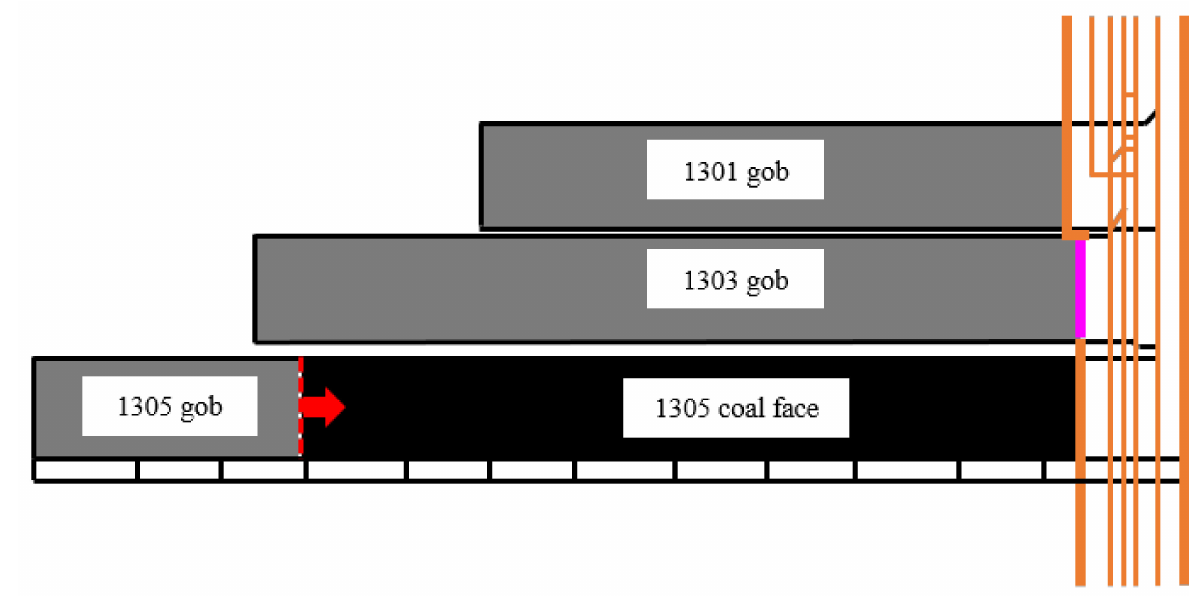
Figure 3. Location of 1305 coal face.